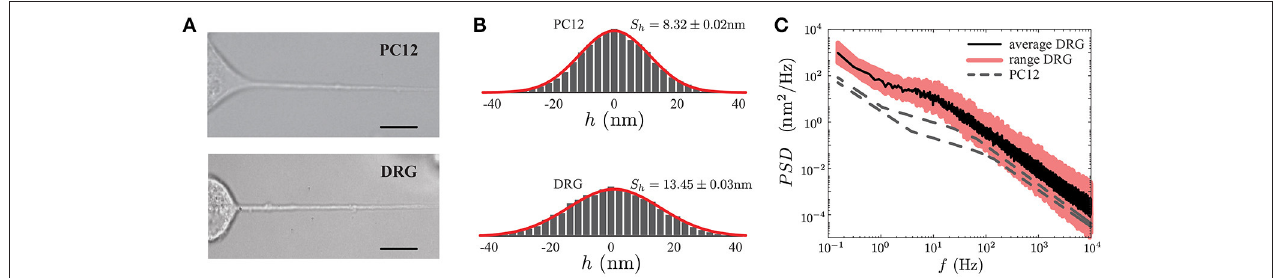
FIGURE 7 | Comparison of PC12 and DRG neurites. (A) PC12 neurite (top) and DRG mouse neuron (bottom) of similar radii and length. Scale bars correspond to 10 µ m. (B) Probability density functions of the fluctuation amplitude for a PC12 neurite (top, S h = 8.32 ± 0.02 nm) and DRG neuron (bottom, S h = 13.45 ± 0.03 nm) respectively. (C) Power Spectrum Density of DRG neuron. The continuous black line corresponds to the average PSD of the DRG samples ( N = 5), whereas the pink region stands for the minimum and maximum PSD ’s of the collected data to show the variability range of these five DRG neurons. As a reference, the PC12 neurites PSD shown in Figure 5A are displayed in gray segmented